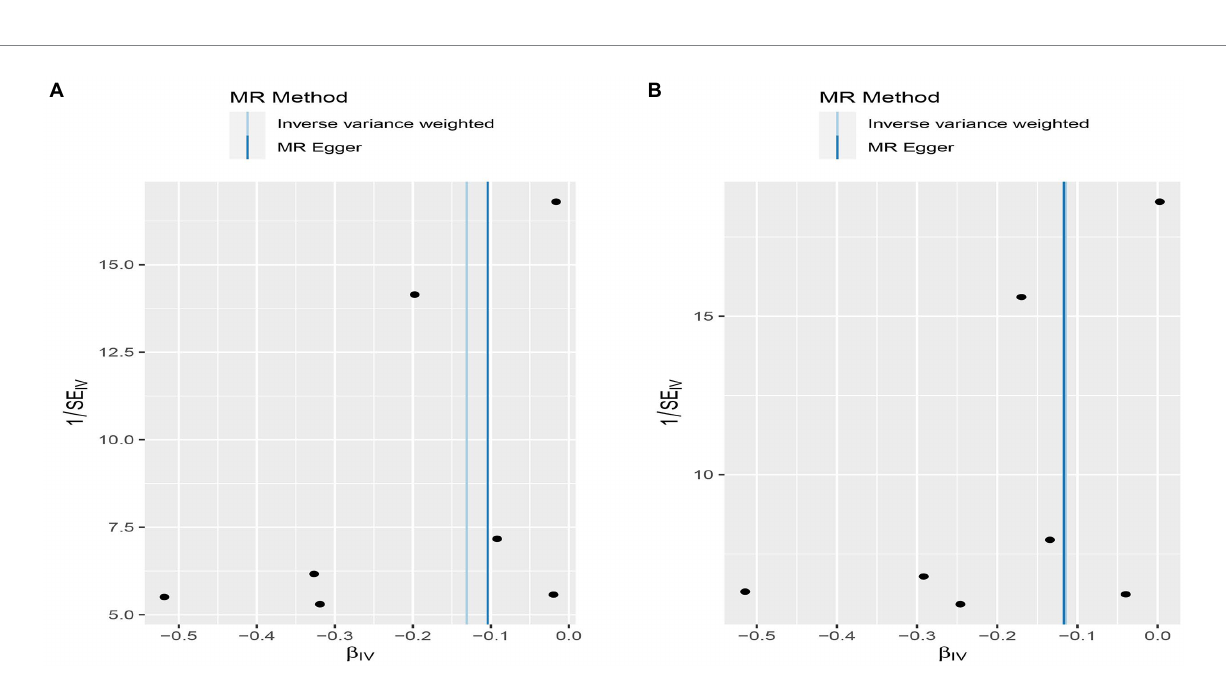
FIGURE 6 Funnel plot MR estimates of genetic risk of OPG on AMI and CHD. The funnel plot of genetic effect of OPG relative to its effect on AMI (A) and CHD (B) , and the distribution of corresponding points reflects the